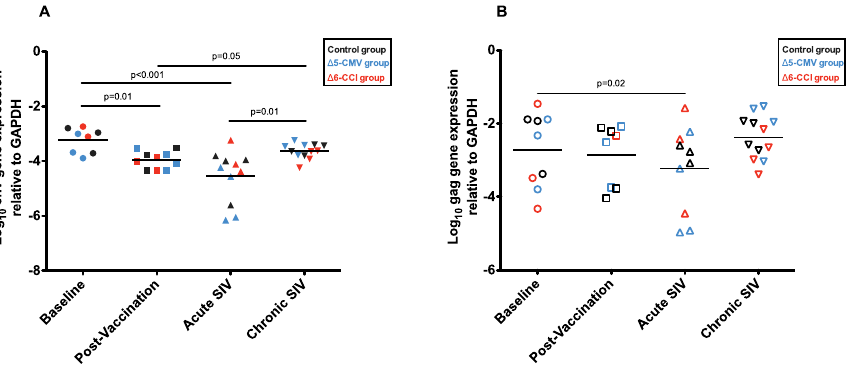
Figure 3. CyERV gene expression in peripheral blood mononuclear cells. CyERV envelope and gag RNA was isolated from PBMCs and quantified using RT-qPCR. Log transformed CyERV envelope (A) and gag (B) gene expression levels relative to GAPDH were compared across all timepoints (baseline, post-vaccination, acute and chronic SIV infection). Post-vaccination PBMCs are comprised of samples from both week 114 and 116. Vaccine groups include controls, D 5-CMV group, and D 6-CCI group. Paired-samples t-tests (2-tailed) were performed to determine statistical significance, bars represent the mean.